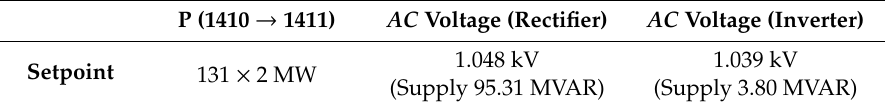
Table 5. HVDC setpoint using the STLM